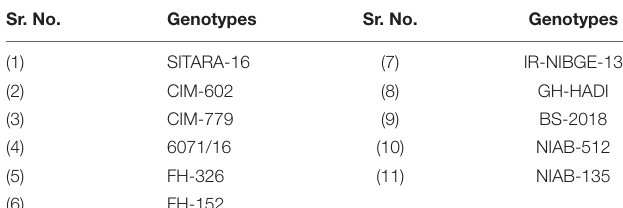
TABLE 2 | Selected genotypes for seedling experiment under glass house